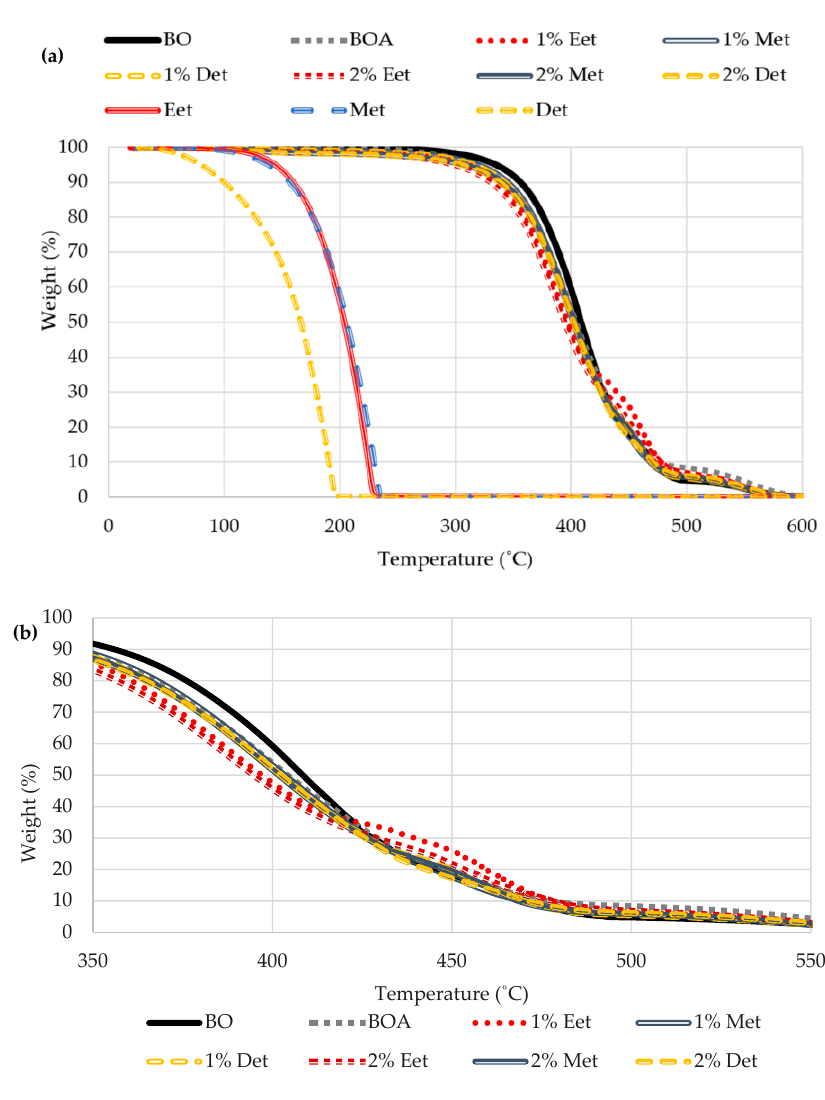
Figure 3. ( a )ExperimentalTGAforBO,BOA,neatPILs, andPILblends, ( b )detailofthethermalgravimetric Figure 3. ( a ) Experimental TGA for BO, BOA, neat PILs, and PIL blends, ( b ) detail of the behavior of the lubricants from 350 to 550 ◦ thermalgravimetric behavior of the lubricants from 350 to 550 °C.